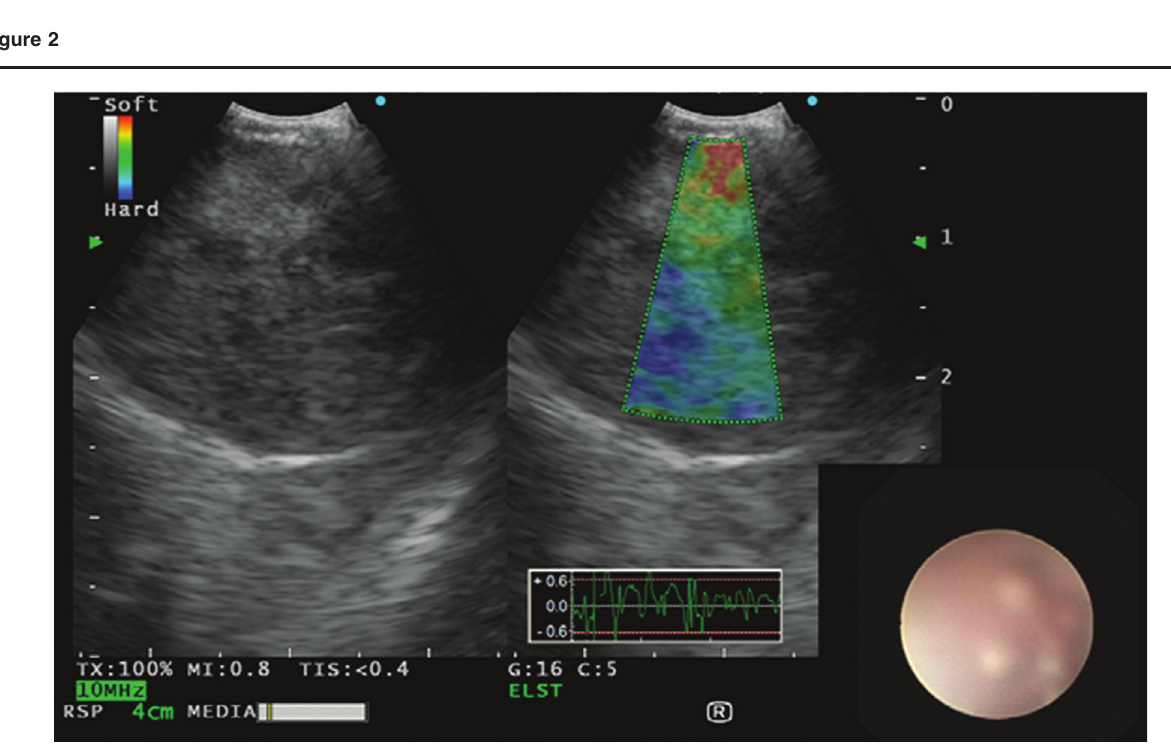
Type 2 can be seen on the elastography